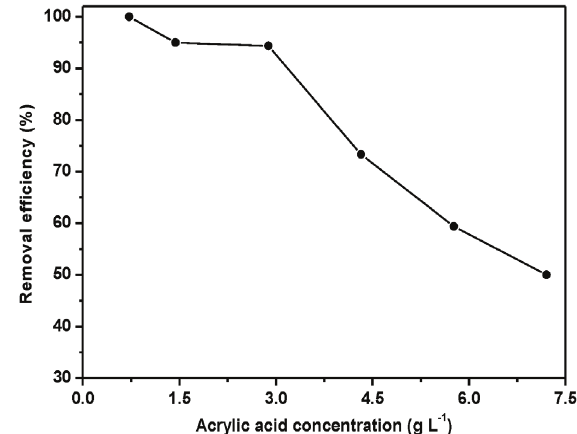
Fig. 5 – Effect of adsorbent dosage on the removal efficiency of acrylic acid onto CaO 125 min)